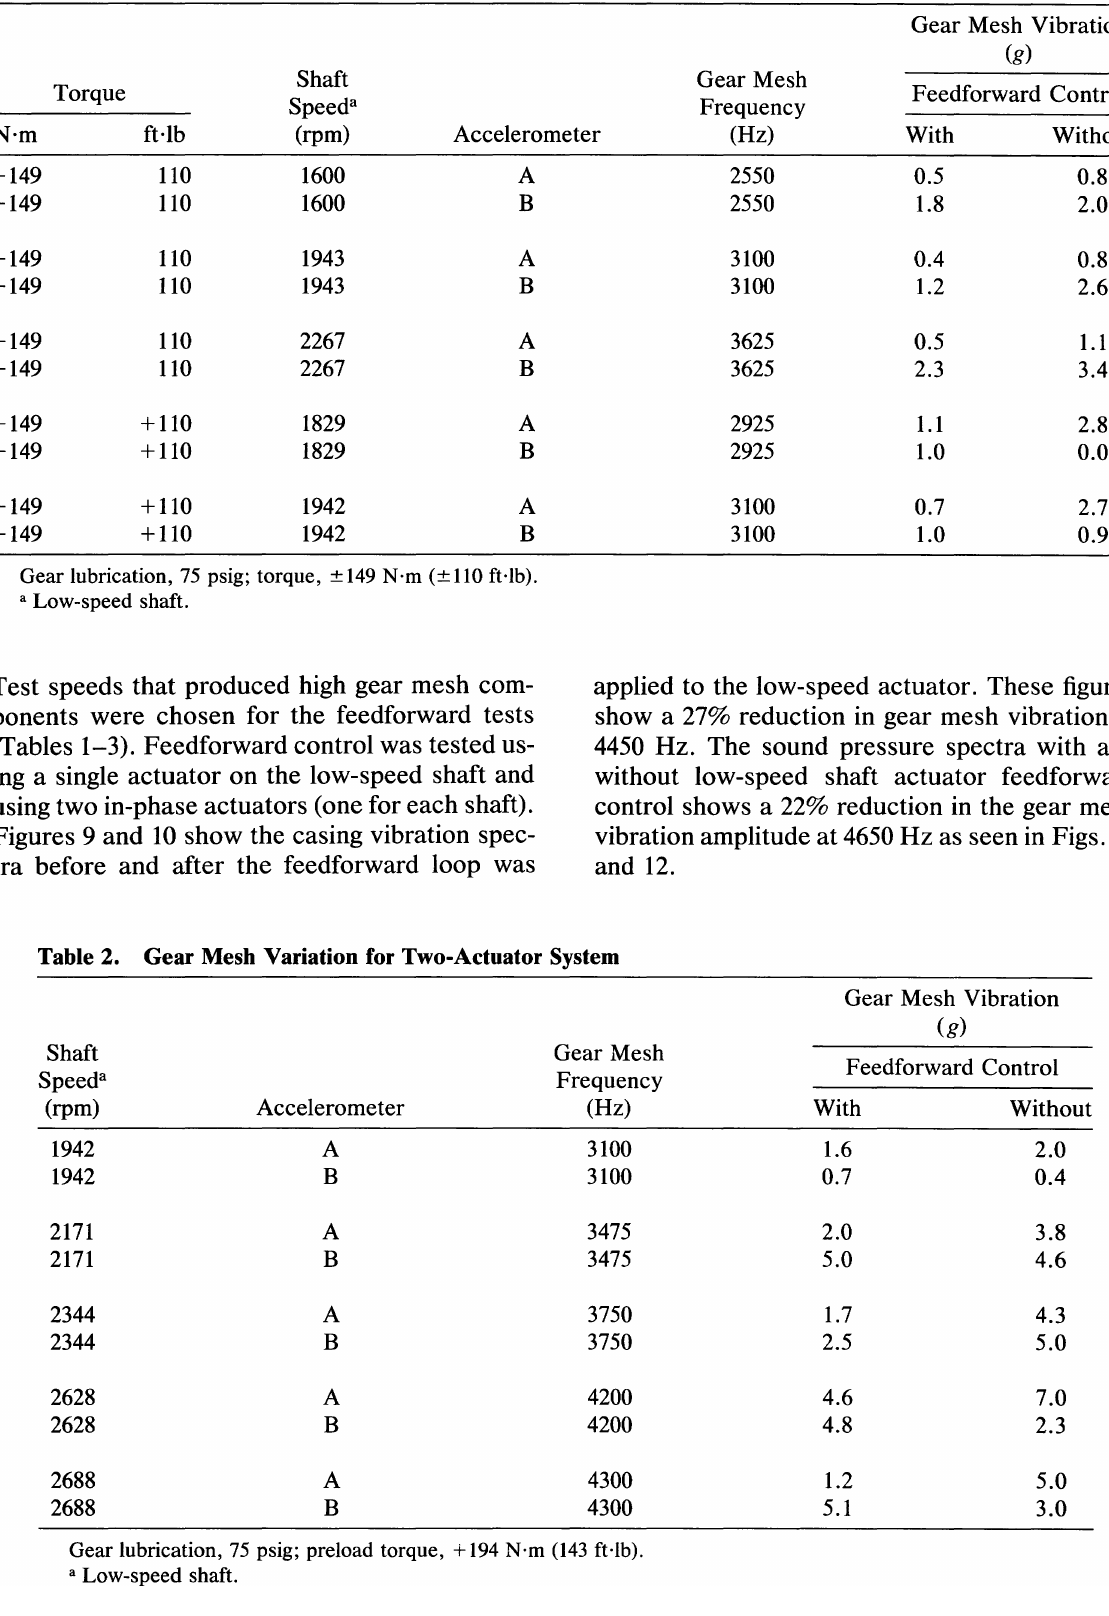
Gear Mesh Vibration Gear Mesh